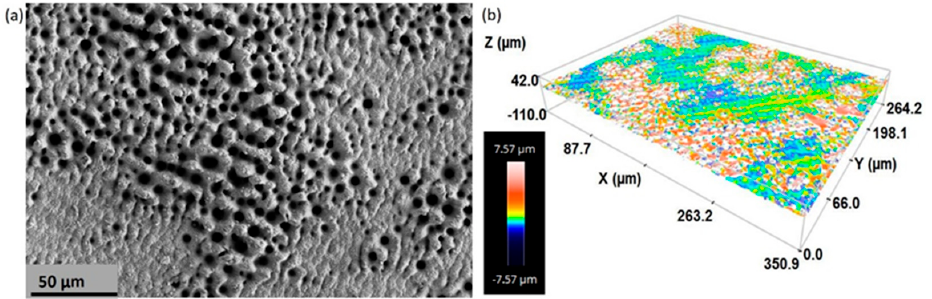
Figure 2. ( a ) SEM (Scanning Electron Microscopy) and ( b ) 3D-CLM (Confocal Laser Microscopy) images of the fully-dense c.p. Ti substrates after femtosecond laser treatment.